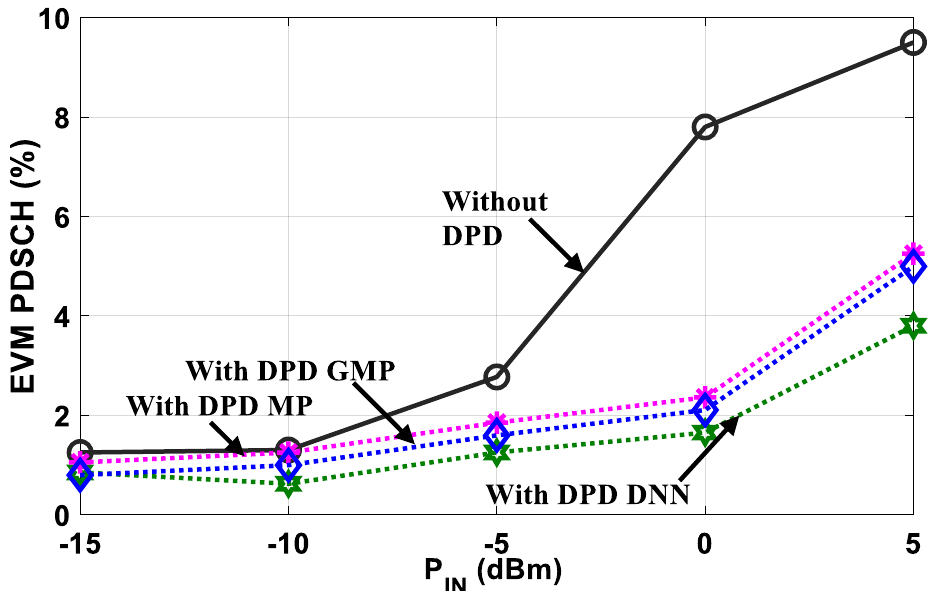
Figure 10. Experimental results for Error Vector Magnitude (EVM) received signal without and with linearization (DPD-NN and DPD-MP/GMP). Table 3. Comparison among DPD methods for 0 dBm input power.